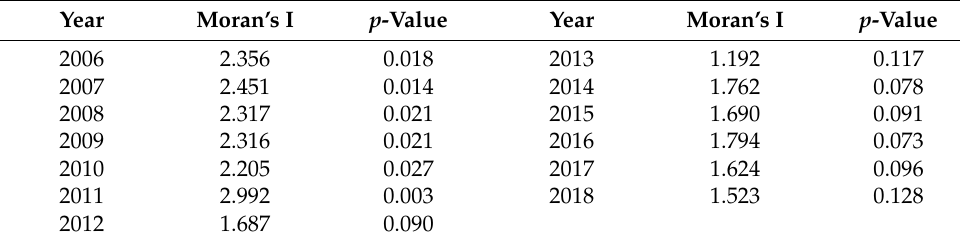
Table 3. Global Moran’s I